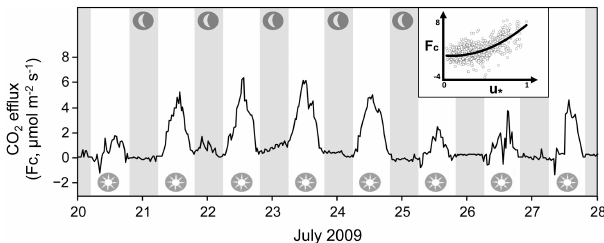
Fig. 1. Measured CO 2 efflux from an ecosystem on carbonate (dry season). Example of a period in which atmospheric turbulence in- duces CO 2 outgassing events during the daytime in a dry Spanish “Matorral” vegetation growing on karst. The inset shows that out- gassing increases exponentially with u ∗ , a measure for atmospheric turbulence. Because of the drought during this time of year, plants are in a dormant stage and the observed daytime CO 2 effluxes have to be attributed to ventilation. In 2009, ventilation was observed here daily from the end of 24 June until the beginning of 7 Septem- ber. The figure shows the clearest case of ventilation, peak day- time effluxes averaged around 2µmolm − 2 s − 1 (ranging between 0.5–6.4µmolm − 2 s − 1 ) in